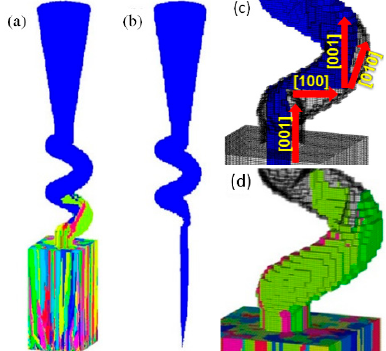
Figure 11. Simulation analysis of general spiral grain selection process: ( a ) microstructure in selector; ( b ) single crystal growth during entire selection; ( c ) single crystal growth directions in local spiral part; and ( d ) microstructures of eliminated grains.